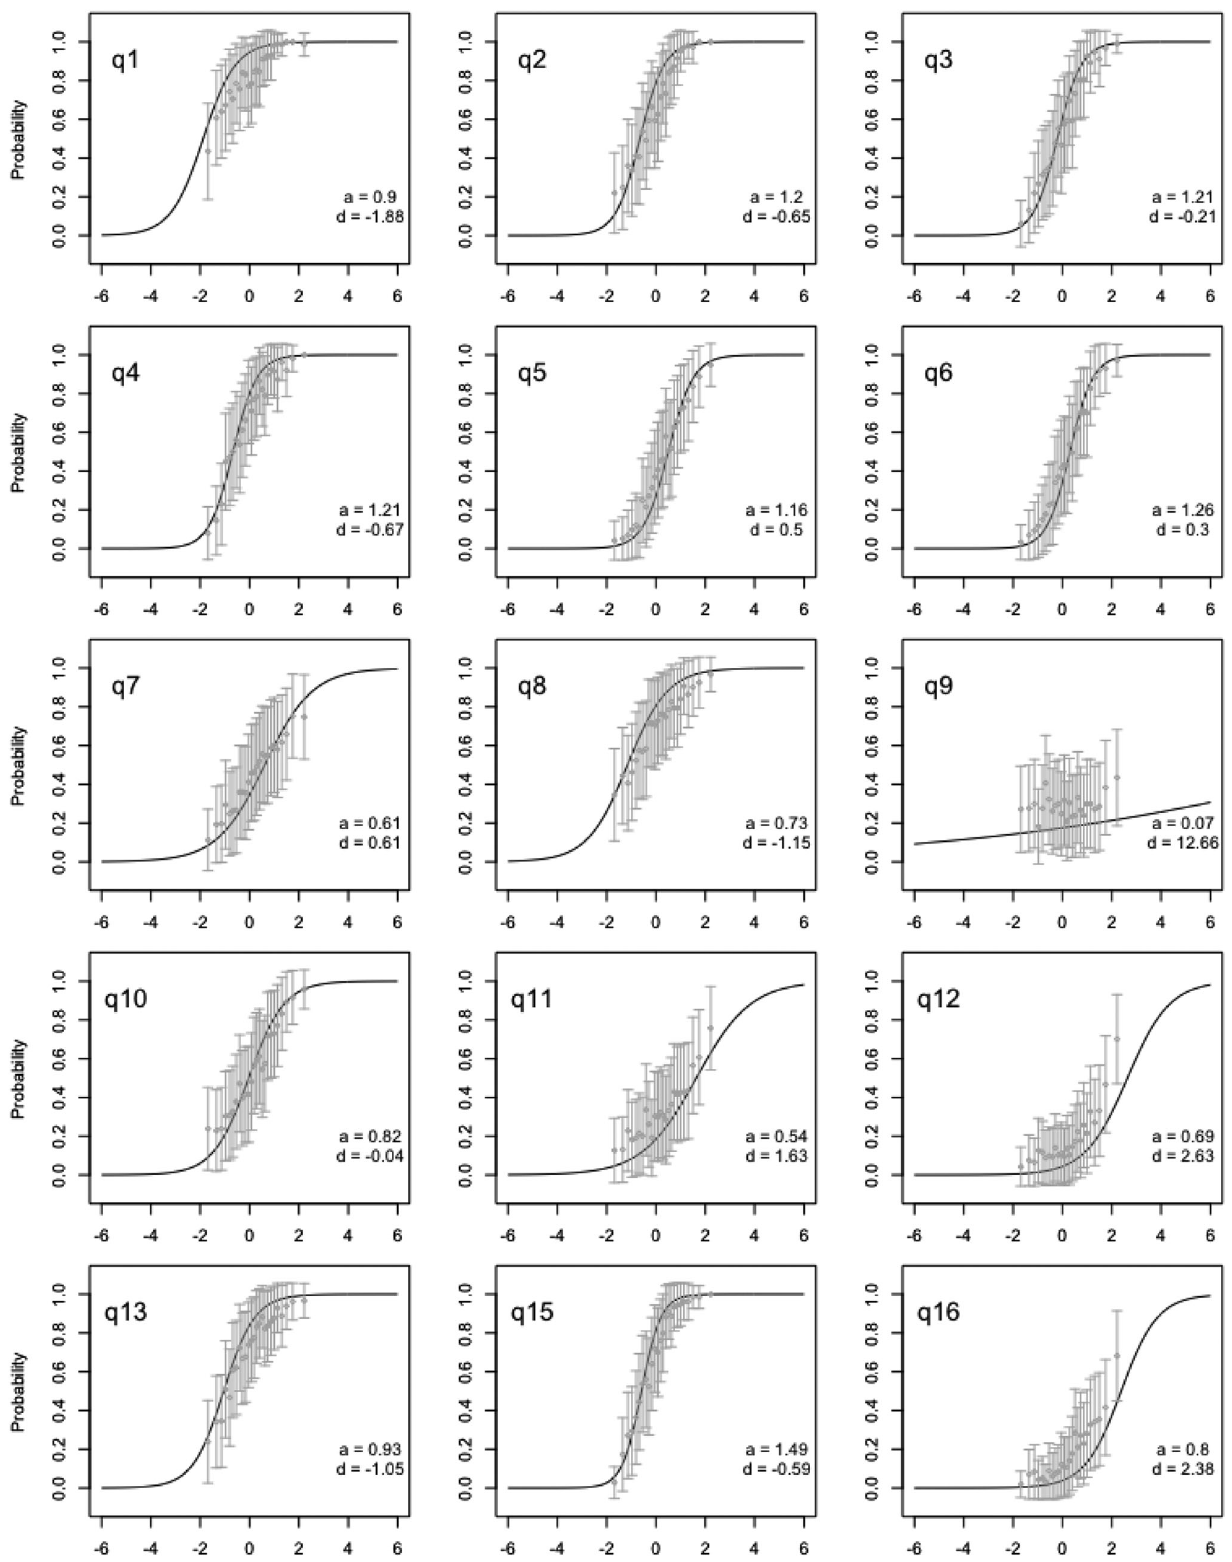
FIG. 11. Item characteristic curves for the item 1 – 15 on the BEMA, in the CSEM scale. The gray error bars represent 1 standard deviation, from top to bottom, in the student responses. The horizontal axis is student latent